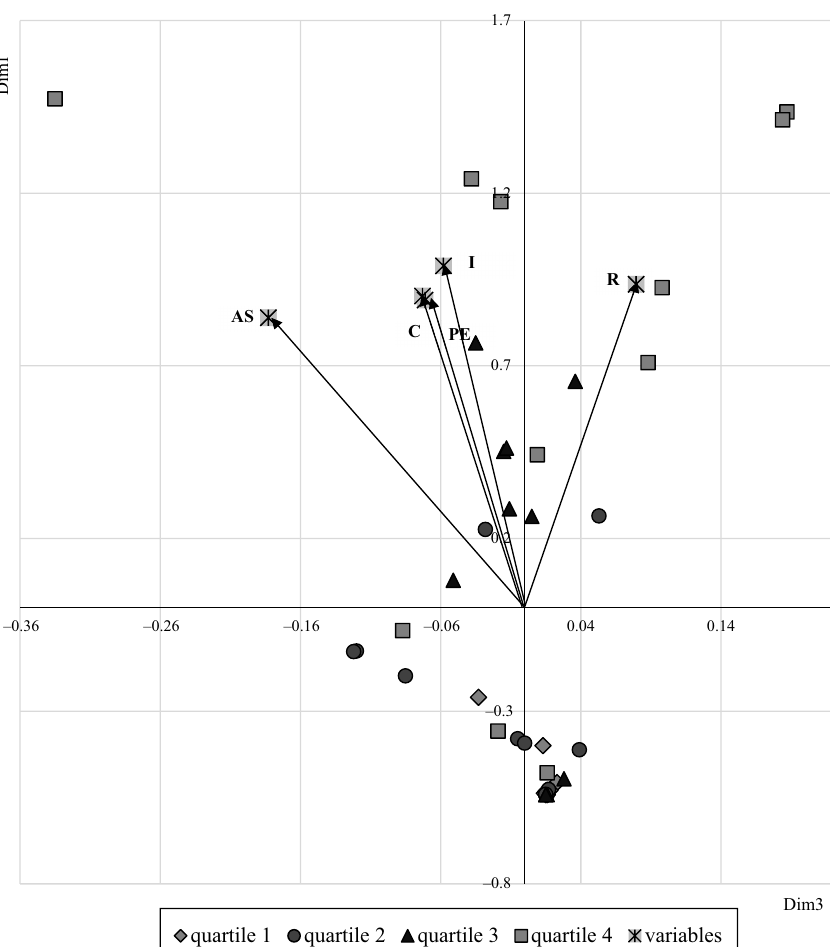
Figure 1. Multidimensional scaling methodology (MDS)